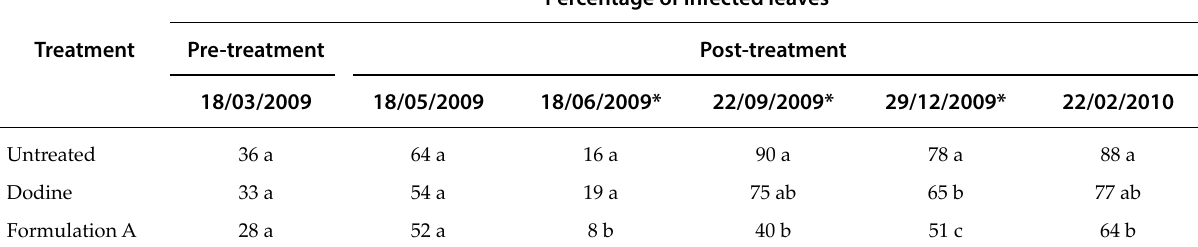
Table 3. Mean proportions of F. oleagineum infected leaves of the susceptible olive cultivar Nocellara del Belice (N.B.). The data were arcsine-transformed before the statistical analysis. Values with different letters are different ( P <0.05), as deter- mined by Fisher’s protected least significant difference